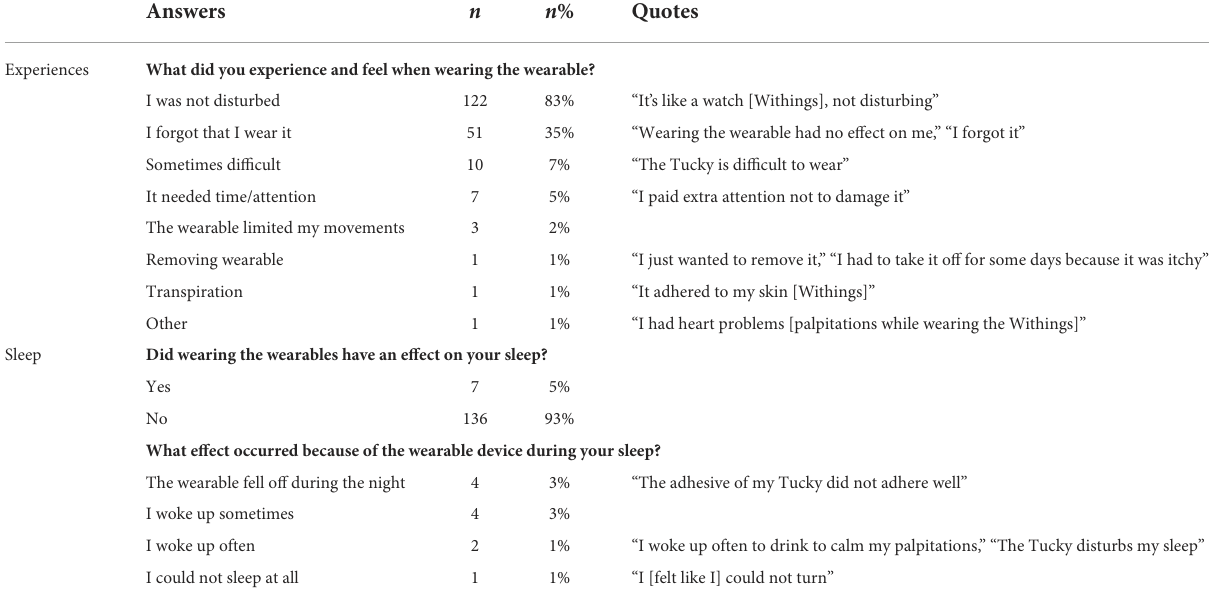
TABLE 2 Overview of key responses to multiple-choice and open-ended questions about participants’ general experiences with wearables and effect on sleep. Answers n n %